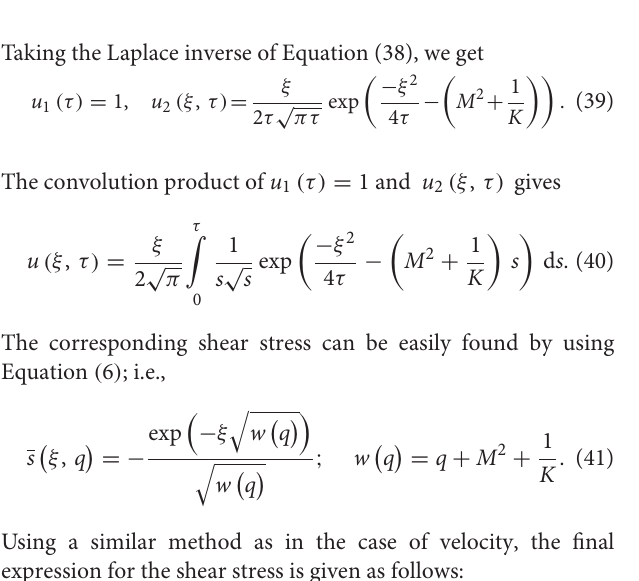
FIGURE 8 | Shear stress plots showing variations in M (Newtonian